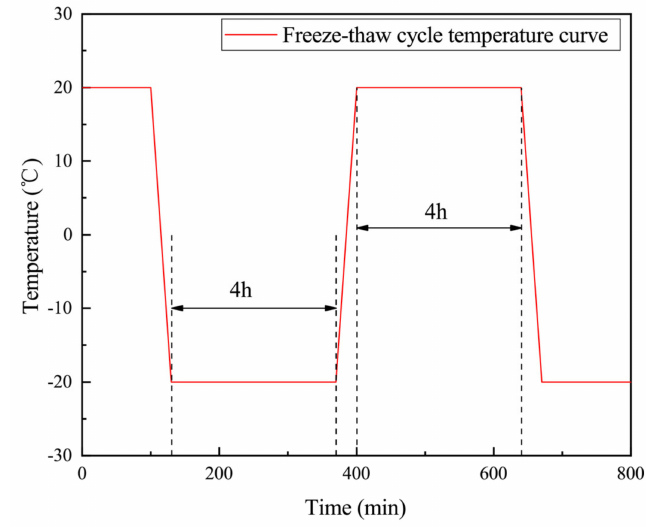
Figure 3. Temperature control curve of the freeze–thaw cycling process.